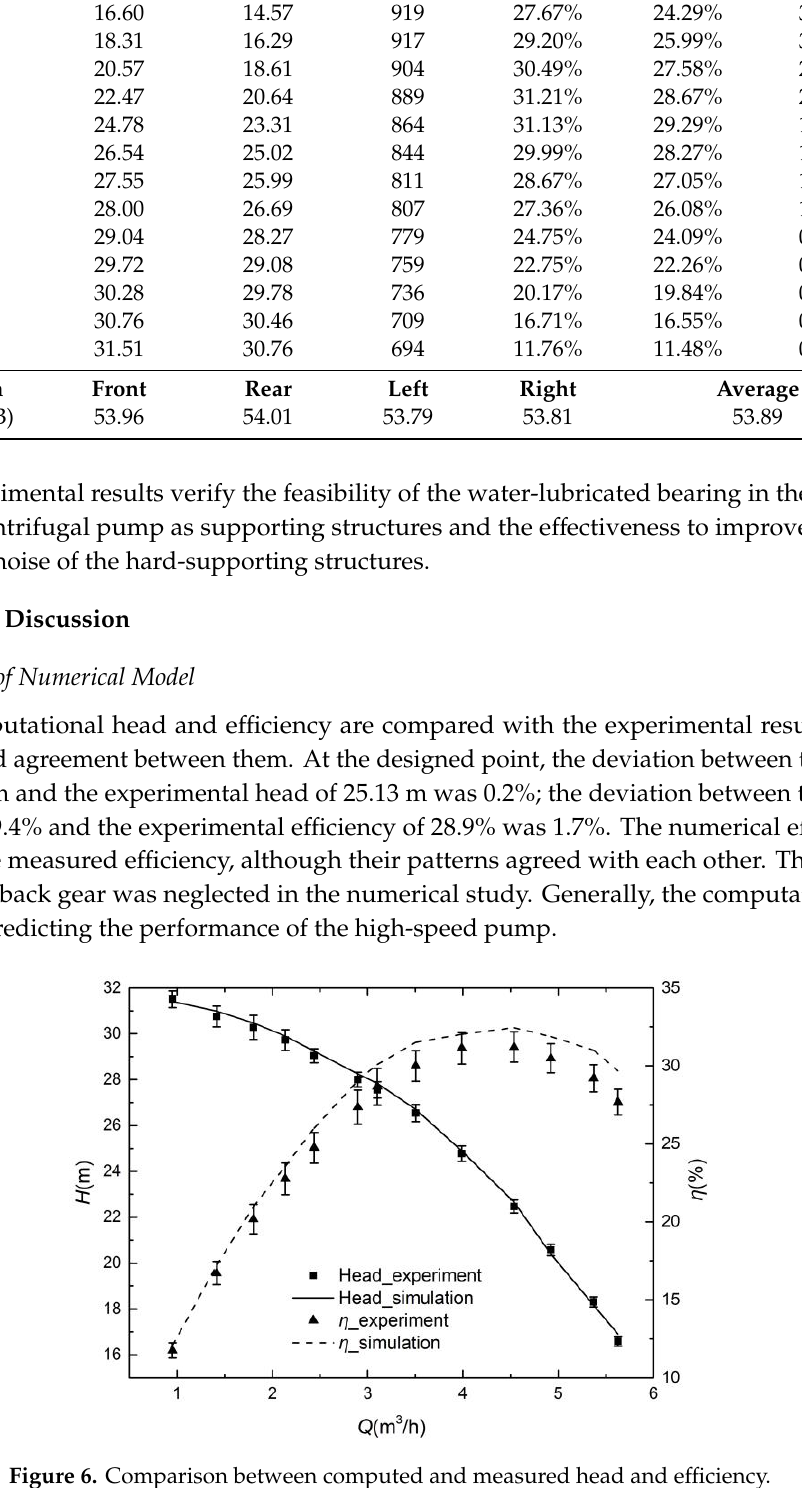
Figure 6. Comparison between computed and measured head and efficiency.